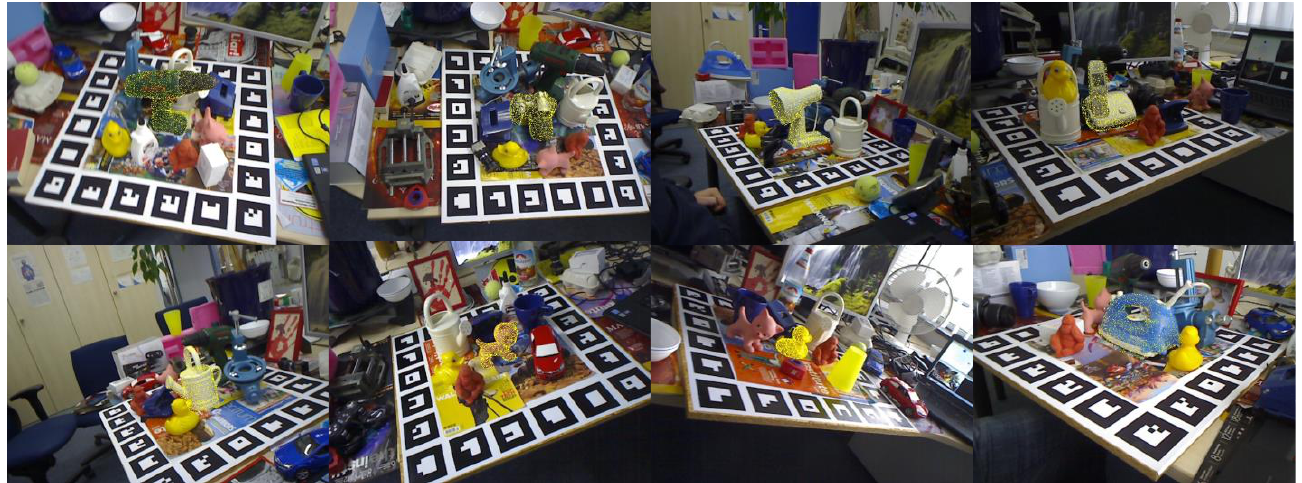
Figure 5. Visualization of results on the LineMOD Dataset.